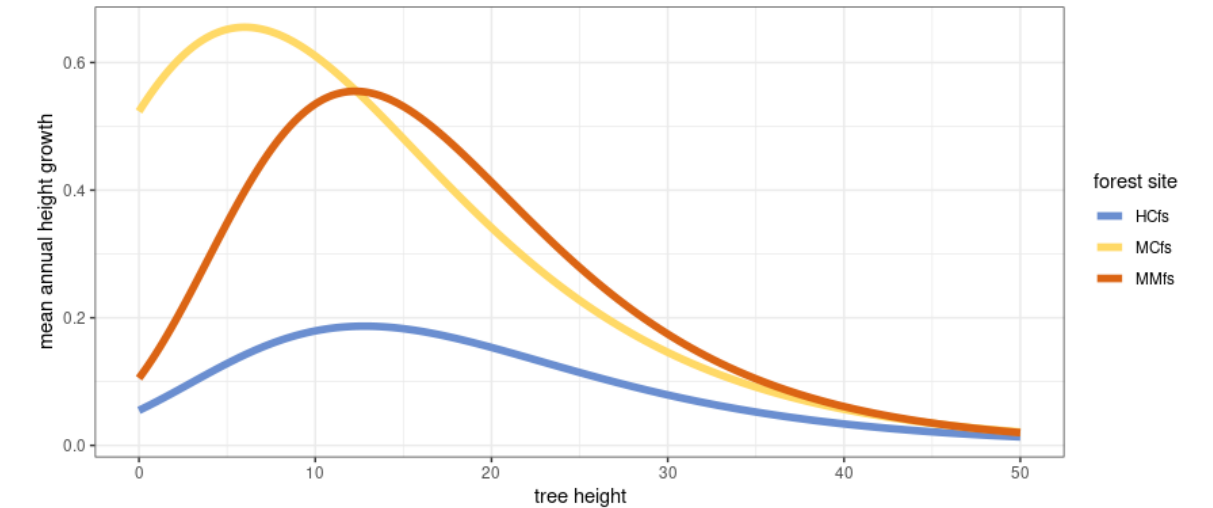
Figure 17. Comparison of the fitted growth functions based on Gompetrz growth curve, an approximation of annual tree height growth based on initial tree height.